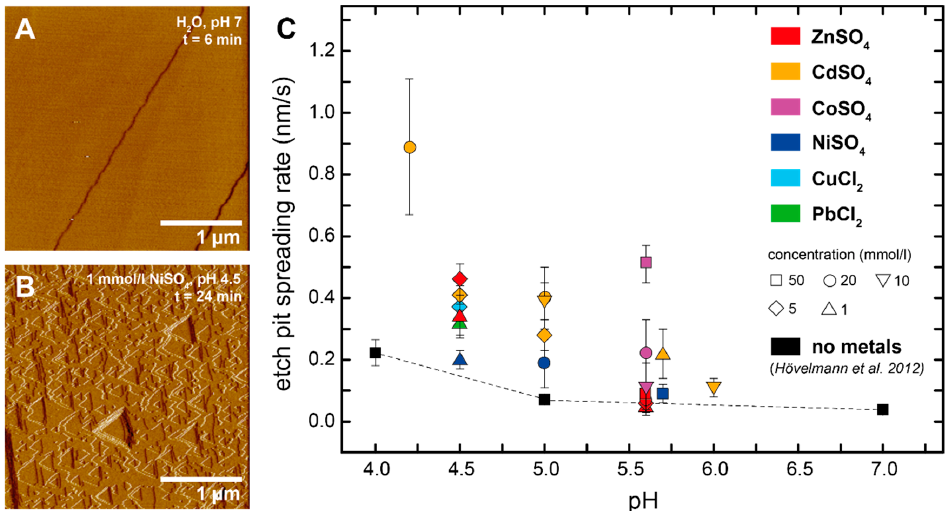
Figure 1. Brucite dissolution in the presence of dissolved metals. ( A ) In situ atomic force microscope (AFM) deflection image of a brucite (001) surface taken after 6 min in contact with pure water. The image shows that brucite surfaces were initially flat, apart from some pre-existing step edges. ( B ) In situ AFM deflection image of a brucite surface taken after 24 min in contact with 1 mmol/L NiSO 4 , pH 4.5. The dissolution of brucite in acidic metal solutions resulted in the formation of triangular etch pits. ( C ) Comparison of etch pit spreading rates in the absence (black symbols) and presence (colored symbols) of dissolved metals. Error bars indicate the standard deviation of the measured values (Table 1). Table 1. Compilation of measured etch pit spreading rates in the presence and absence of dissolved metals.